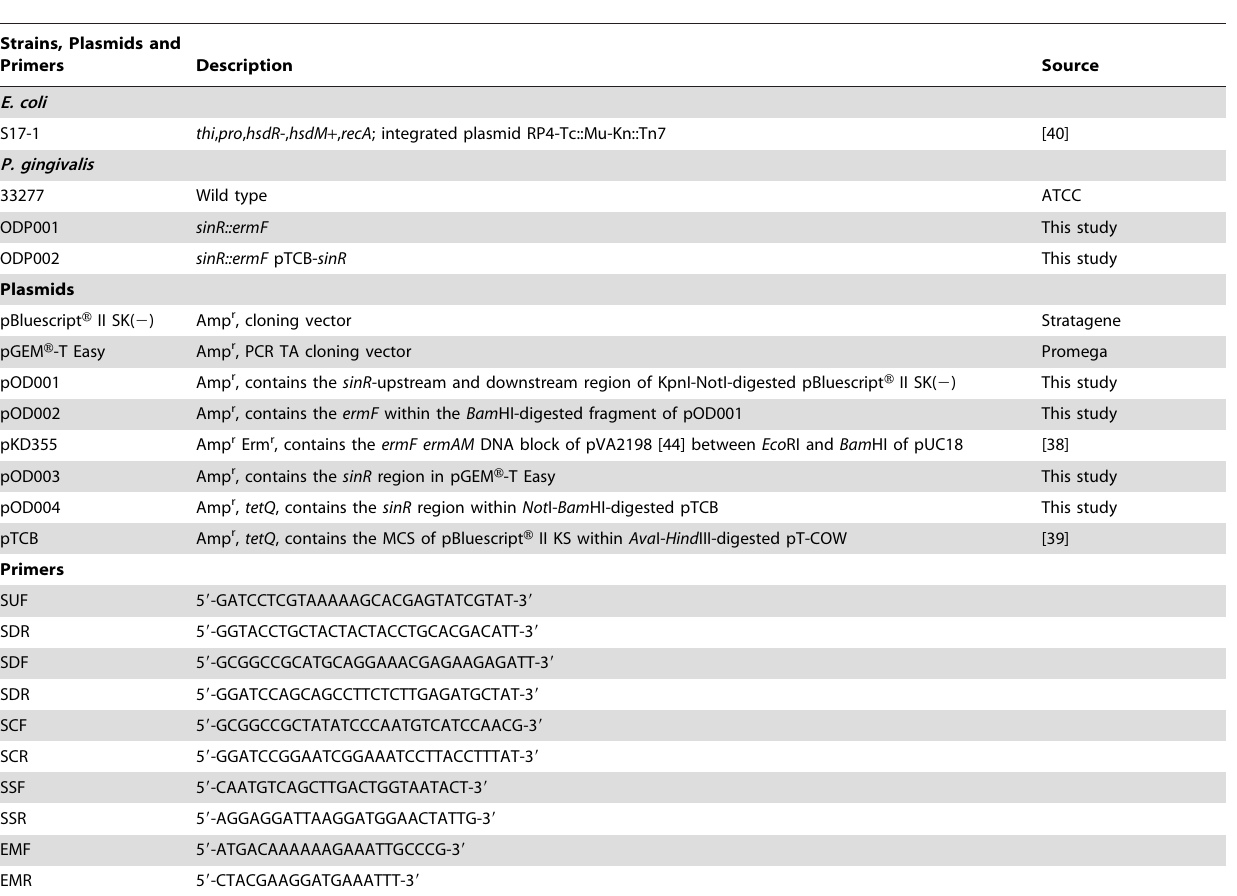
Strains, Plasmids and Primers Description